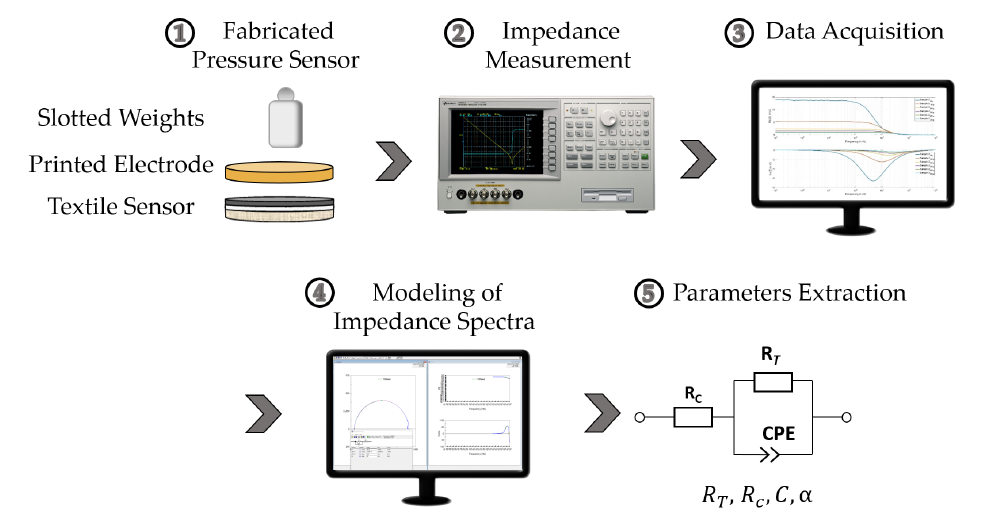
Figure 4. Methodology of the investigation based on impedance